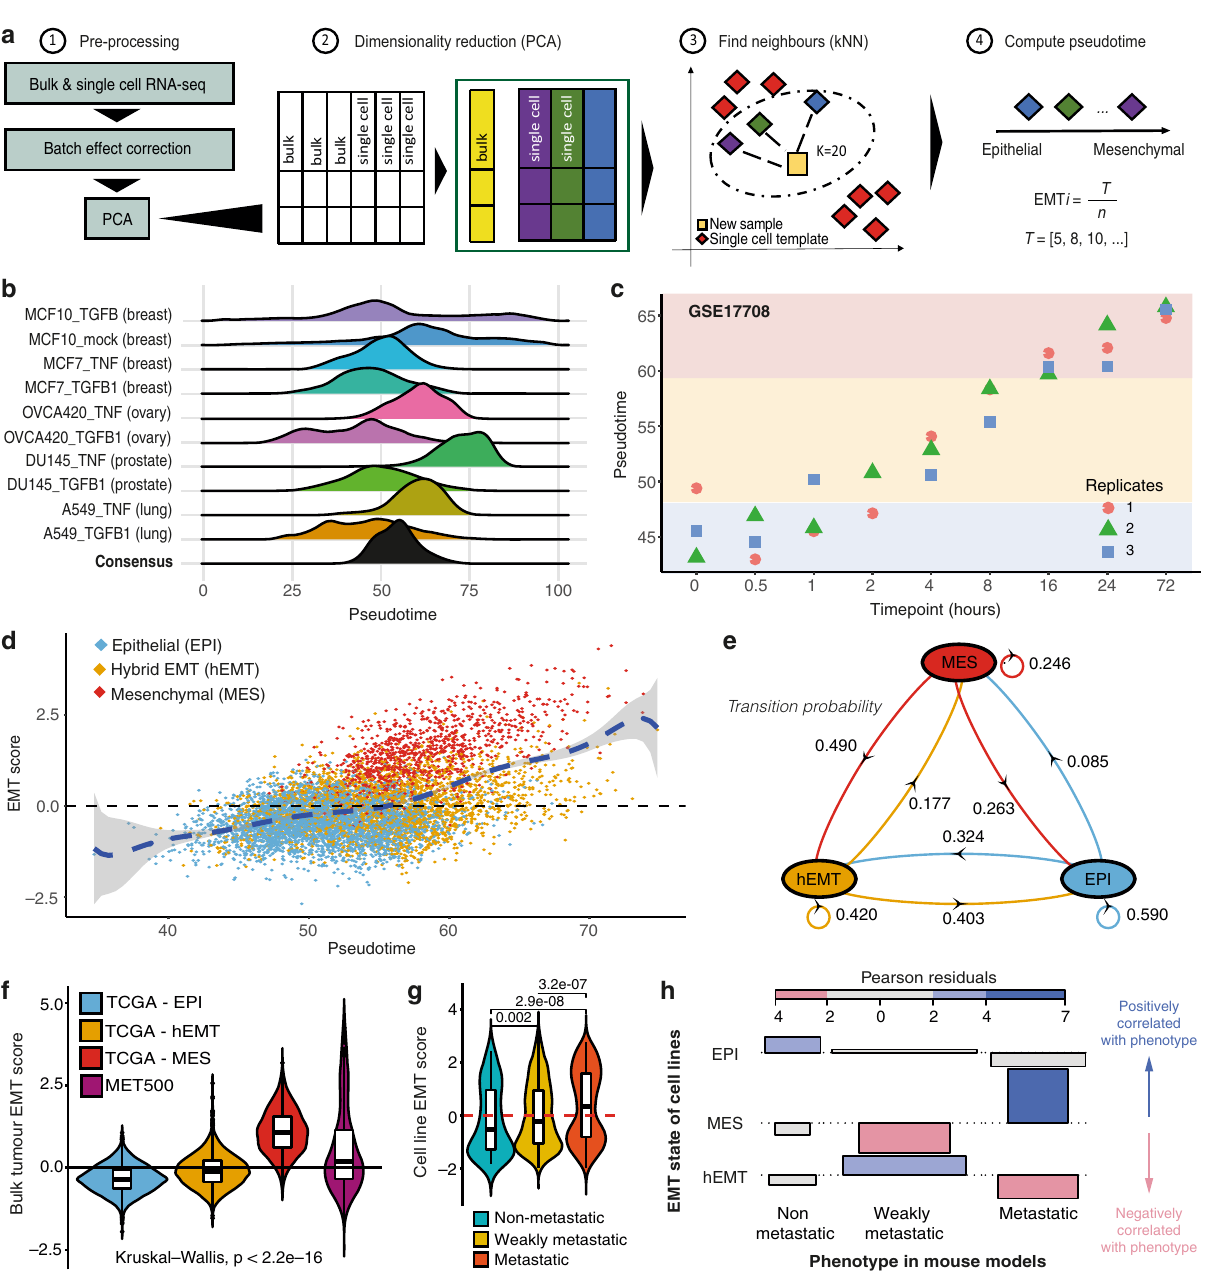
Fig.1|ReconstructionandvalidationofEMTtrajectoriesfromtranscriptomics data.a Work fl